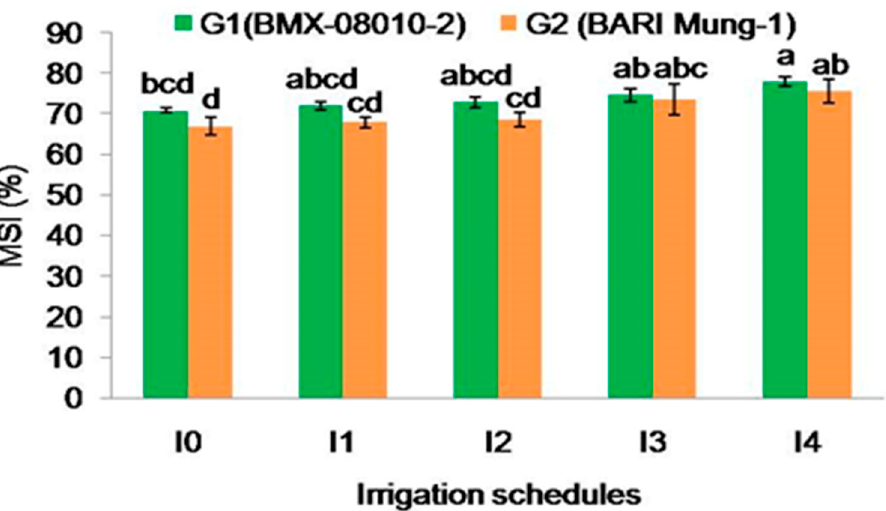
Figure 4. Membrane stability index of selected mung bean genotypes under different irrigation schedules (Data followed by the same letter are not differed significantly by LSD test at p < 0.05).